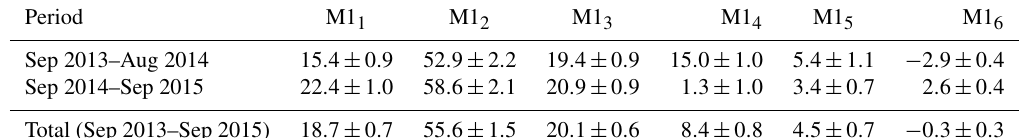
Table 2. Depth-integrated water transports (along-slope, m 2 s − 1 ) in the 0–780m layer in 2013–2015 at six moorings at the Laptev Sea slope.